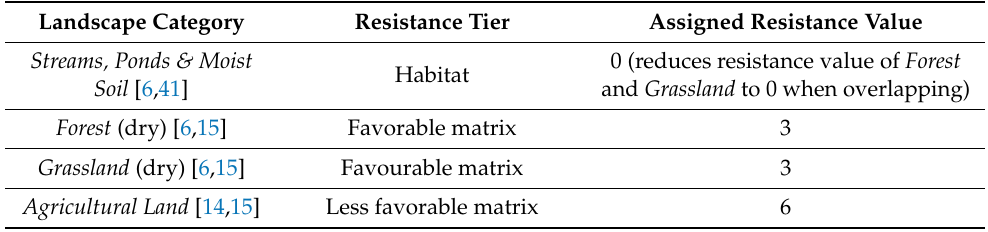
Table 1. Landscape categories with resistance tier list and corresponding resistance values for REF layer. References: [6,14,15,41,42]. All raster layer (except Agricultural Land , A2 Motorway and A2 Underpasses ) © by European Union, Copernicus Land Monitoring Service 2018, European Environment Agency, copernicus.eu [Accessed: 1 June